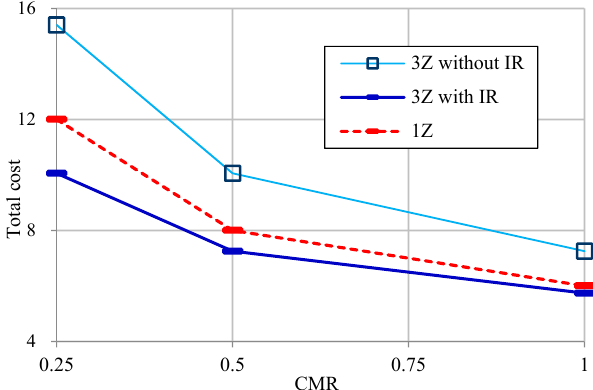
Figure 12. Effect of implicit registration by outgoing calls ( θ = 0.3). Figure 12. E ff ect of implicit registration by outgoing calls ( θ =